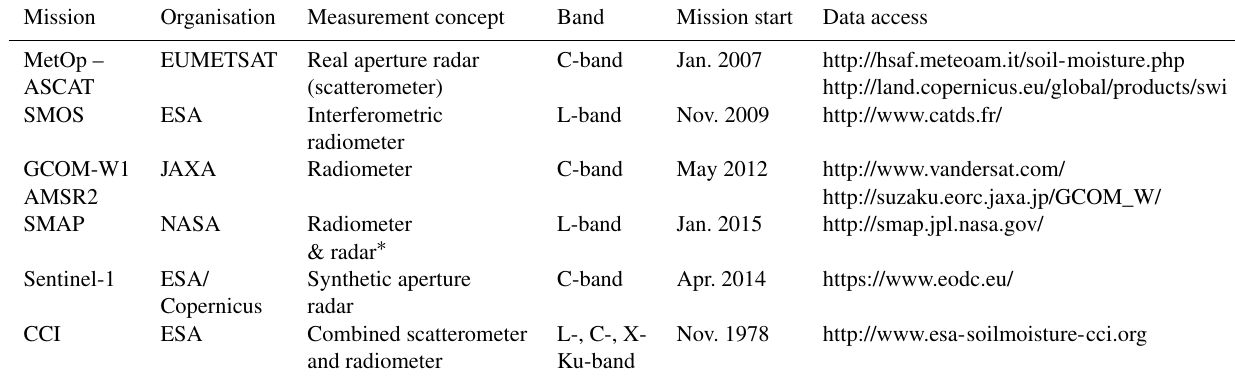
Figure 4. Maps of sun-induced fluorescence (SIF) for July 2010 derived from GOSAT, GOME-2 and SCIAMACHY satellite data. Table 4. Current (pre-)operational global soil moisture missions and products (see the list of acronyms). Mission